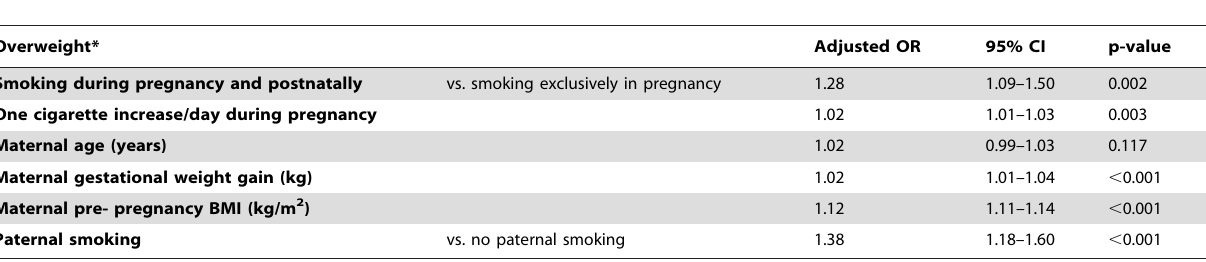
Table 3. The table shows the odds ratios (OR) with 95% confidence intervals (CI) of overweight at age 7 years in children exposed to smoking both during pregnancy and postnatally compared with children exposed only during pregnancy, while adjusting for quantity of prenatal